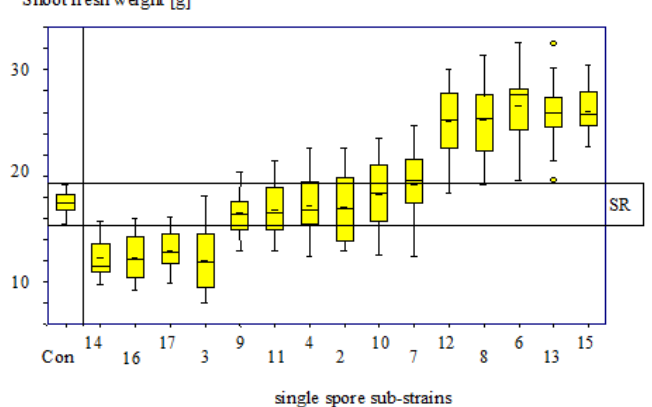
Fig. 4: Increase of variance of fresh weight of Petroselinum crispum by my- corrhizal strains after three subsequent multiplication cycles (data derived from F eLDmann ,